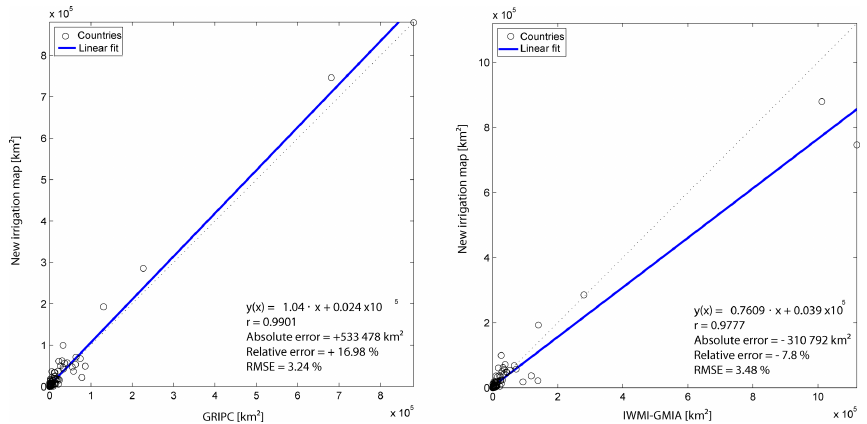
Figure 9. Regression plots of the two compared global data sets. The blue line is the linear fit and the dotted black line the linear equation.